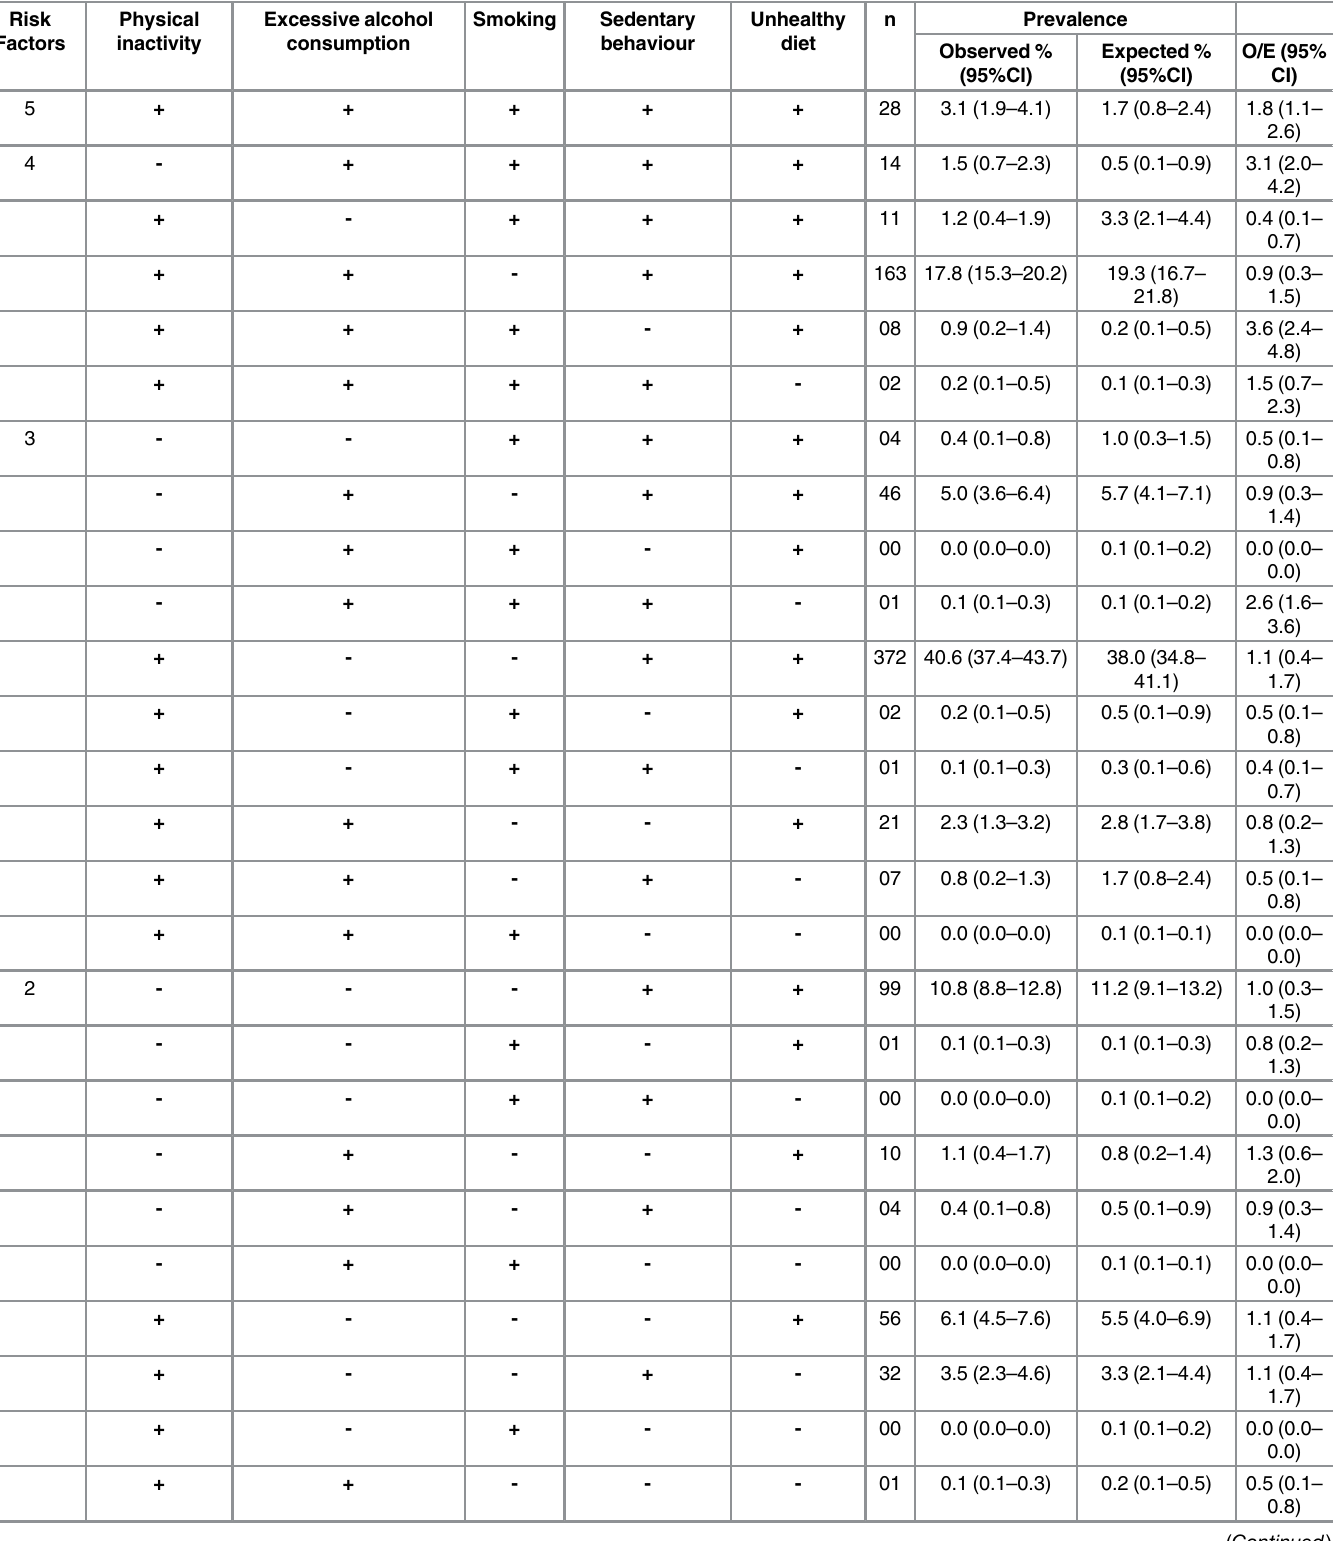
Table 3. Prevalence of combinations of health risk behaviors in the adolescent